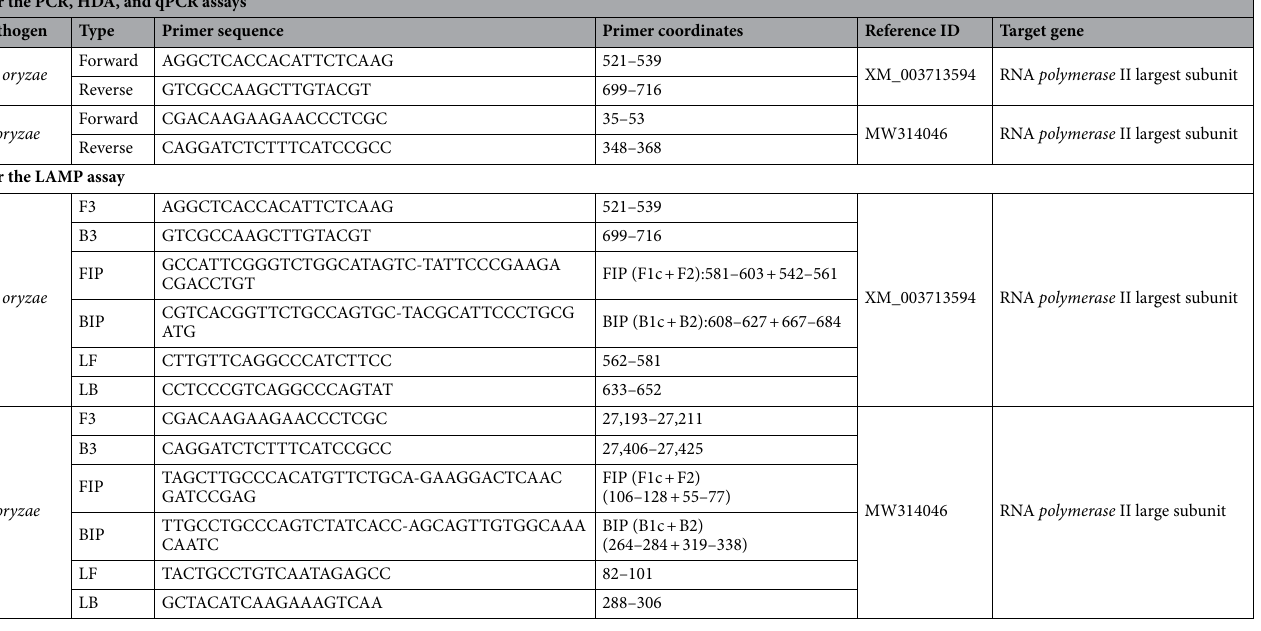
Table 1. Oligonucleotide primers used for different